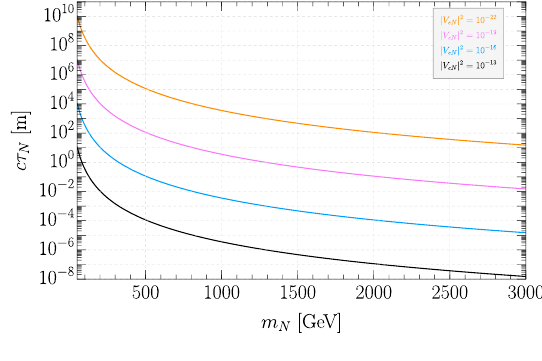
Figure 3 . cτ N vs. m N , for different values of | V eN | 2